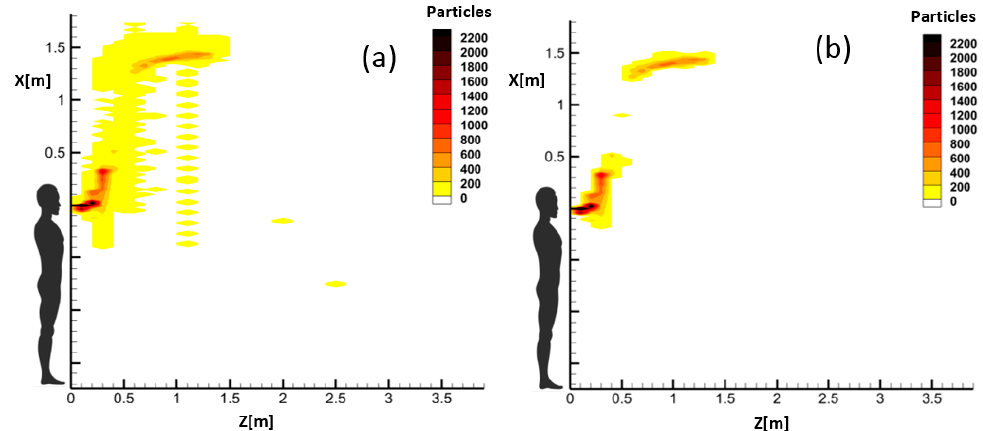
Figure 8. ( a ) Accumulated droplets, and ( b ) regions with more than 100 accumulated droplets within 60 s of simulation time of an exhalation